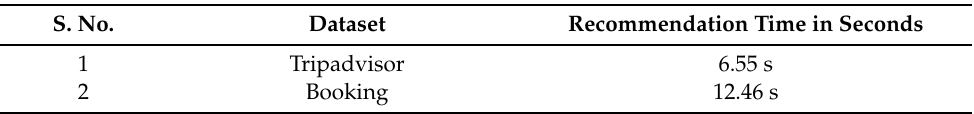
Table 15. Runtime comparisons of our proposed method for the 214 common Hotels of Booking and